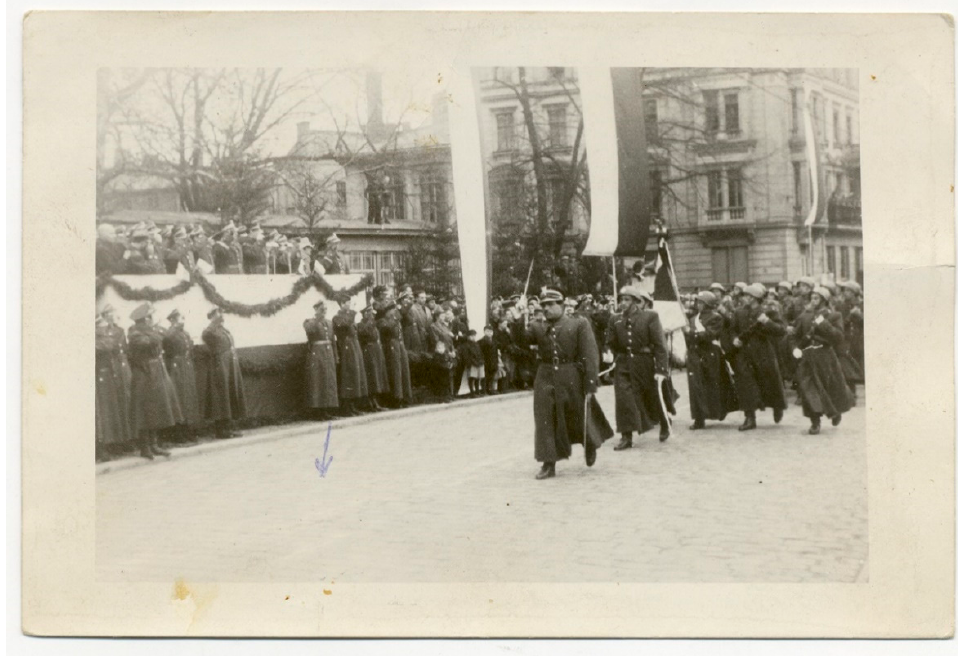
Figure 9. People’s Army of Poland, Legnica, Poland. Adam Kulik marked with an arrow. This simple, ageing photograph of Adam Kulik in Legnica, pointed out with an ar- row from a row of identical uniformed and saluting soldiers on a cold day in 1947, offers the intimate seeing experience that is the antithesis to the ‘Eastern European, post-Soviet visuality’ of All the Missiles are One Missile : the dazzling, manipulated, politically critical,